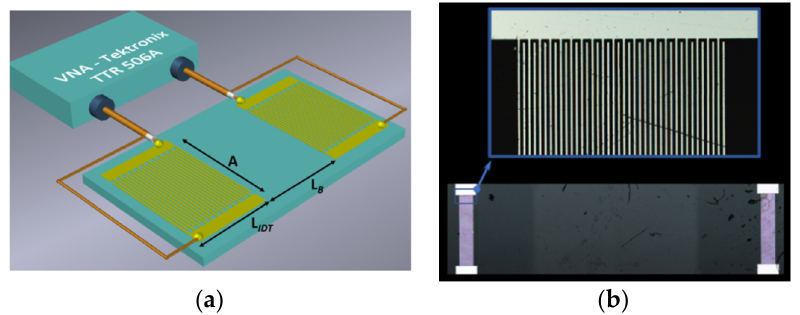
Figure 6. ( a ) Schematic view and ( b ) optical image of the Rayleigh SAW delay line (device #2).